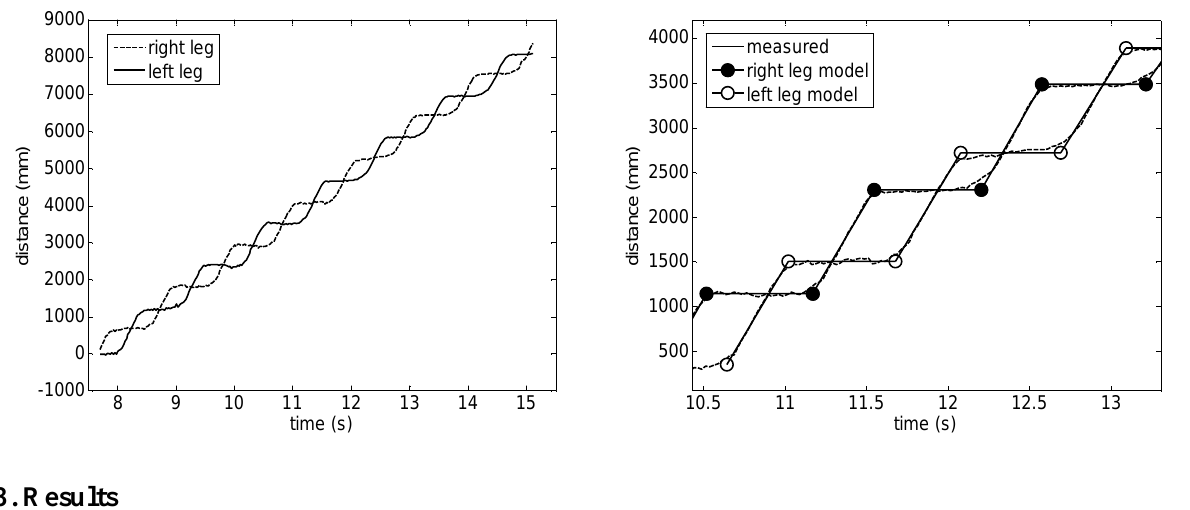
Figure 11. Left: leg displacement while walking. Right: detail of the step-line